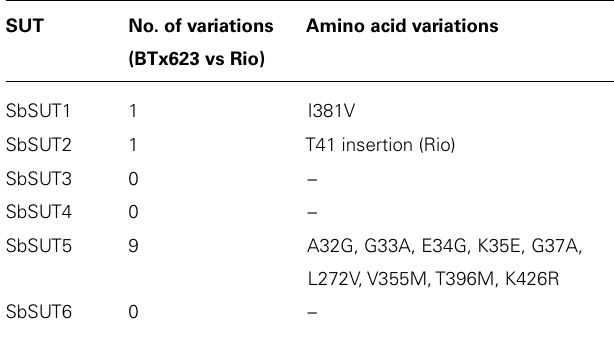
Table 2 | Summary of SUT sequence variation between BTx623 and Rio